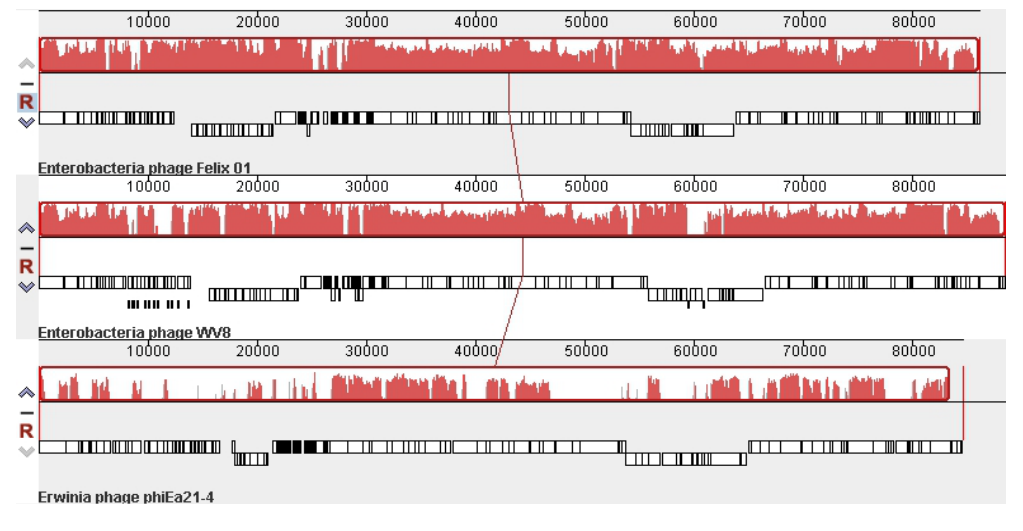
Figure 2. Mauve alignment of the genomes of phages Felix O1 (top), wV8 (middle) and φ Ea21-4 (bottom). The degree of DNA sequence similarity is indicated by the height of the red-coloured regions. Just above the phage names are box-like diagrams indicating the position of the